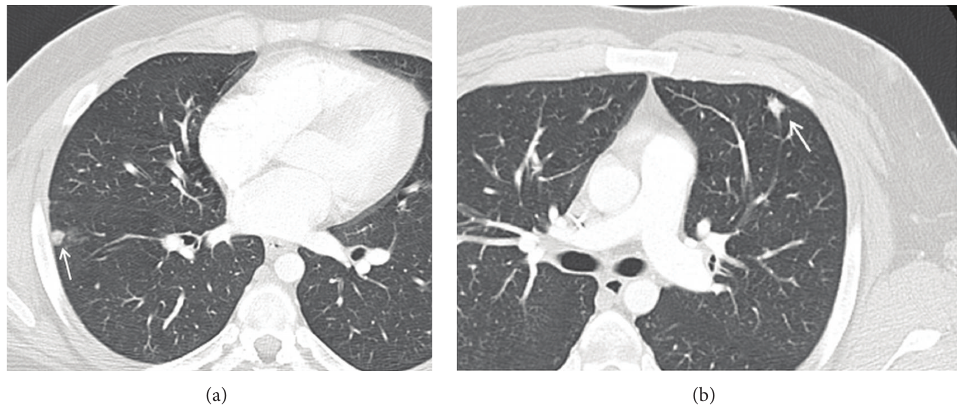
Figure 4: ((a) and (b)) Axial CT scan images of the chest reveal small subcentimeter nodules in the right lower lobe (arrow in (a)) and left upper lobe nodule (arrow in (b)), suspicious for pulmonary metastases.